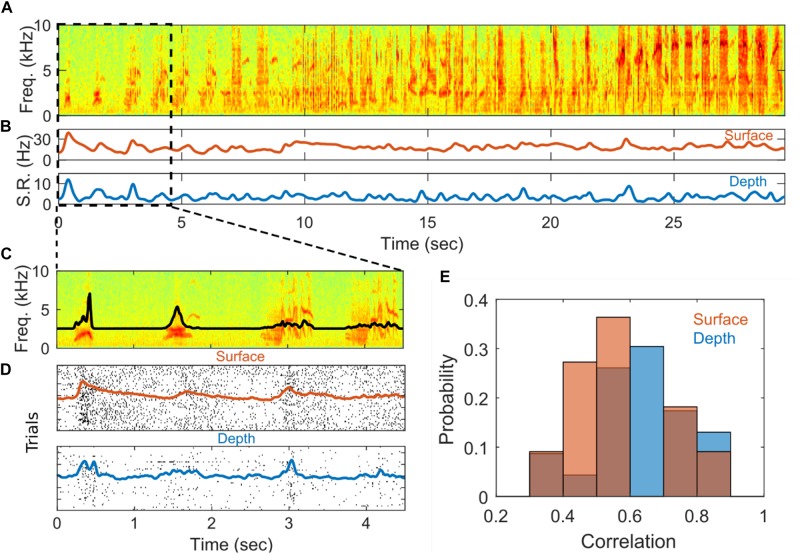
Stimulus driven responses. (A) Example spectrogram of a stimulus, Bird’s-own-song presented during electrophysiological recording. (B) Averaged smoothed spike rate for single units recorded from the surface (red) and depth (blue) arrays. The average spike rates were smoothed with a 5-point Gaussian window with a standard deviation of 0.4. (C) Zoom-in of first 4.5 s of (A). The black line shows the amplitude envelope of the stimulus. (D) Spike raster plots showing the times of individual spiking events on each of 54 successive stimulus presentations for the surface (red) and depth (blue) SUAs in (B). The red and blue lines show the smoothed spike rates averaged across stimulus presentations for the surface and depth units, respectively. The spike rates were smoothed with a 30-point Gaussian window a standard deviation of 0.4. (E) Distribution of correlation values for depth (blue) and surface (red) for units that are significantly correlated with onset of the auditory stimulus.